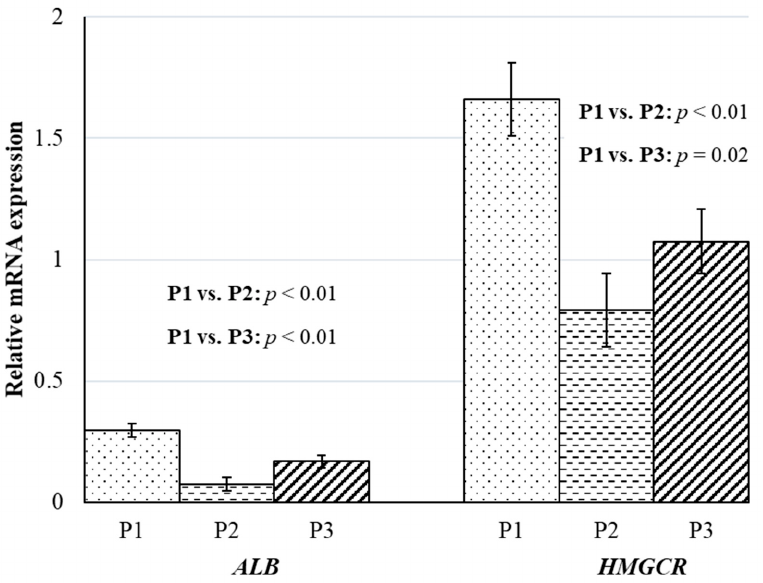
Figure 2. Impacts of time-fed concentrate-based diets on relative mRNA expression of hepatic negative acute phase reactants of wethers. The experiment was divided into three phases: P1 (day 0 to 21), P2 (day 22 to 25), and P3 (day 22 to 49). During P1, all wethers ( n = 13) were fed the 80% forage diet. On day 22, the remaining nine wethers were fed an 80% concentrate diet. The contrasts between wethers sampled in P1 ( n = 4) and P2 ( n = 4) and between wethers sampled in P1 ( n = 4) and P3 ( n = 5) on LS means of relative mRNA expression of Albumin ( ALB ) and 3-hydroxy-3-methylglutaryl-CoA reductase ( HMGCR